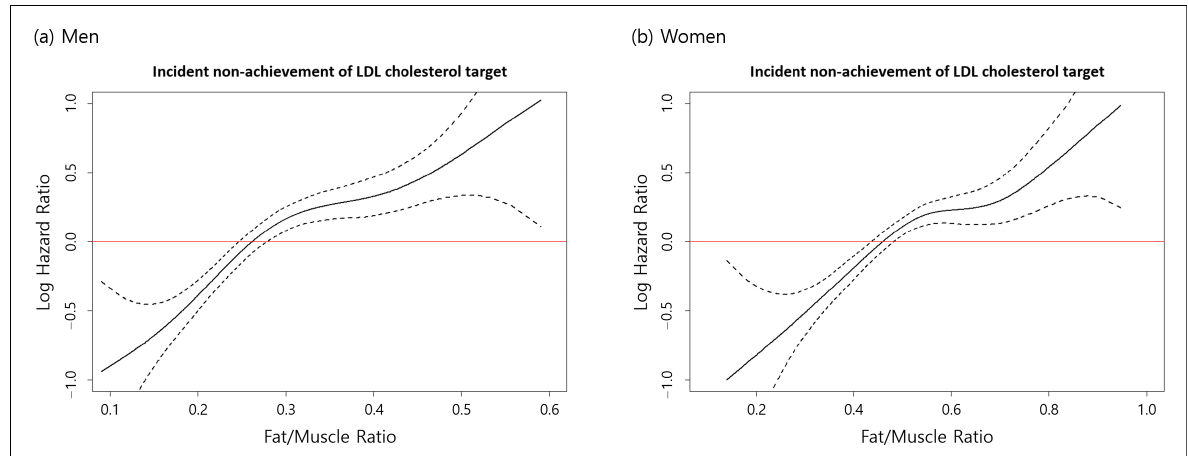
Figure 2. Relationship between the incidence of non-achievement of LDL cholesterol targets and FMR in ( a ) men and ( b ) women. Graphs showing the incidence of non-achievement of LDL cholesterol targets according to FMR (solid lines), with 95% CI bands (broken lines) according to the Cox proportional hazard spline curve. Abbreviations: LDL, low-density lipoprotein; FMR, fat-to-muscle ratio; CI, confidence interval.